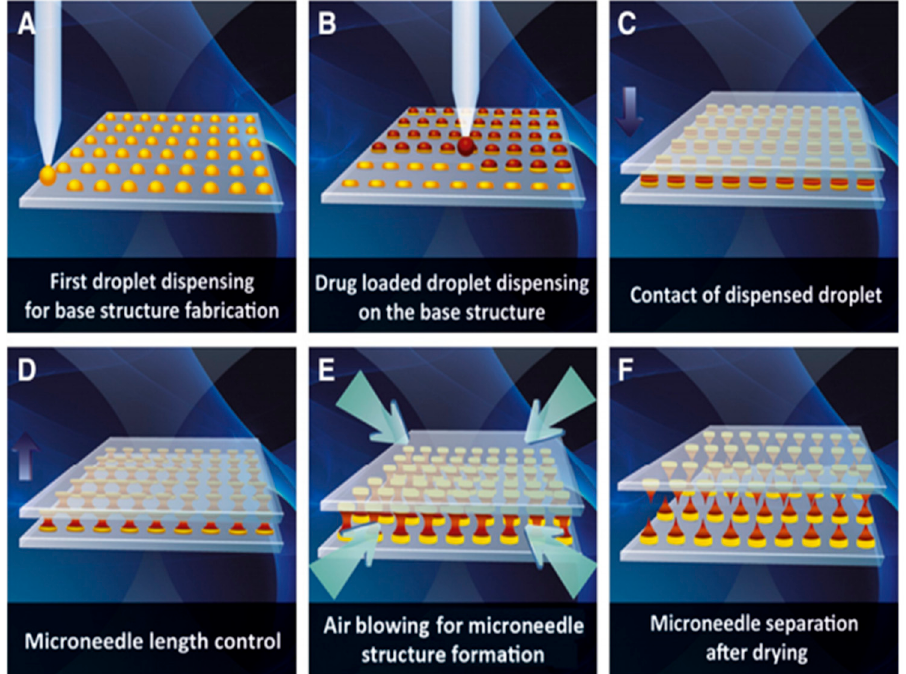
Figure 8. Schematic illustration of dissolving microneedle fabrication via droplet-born air blowing method. ( A ) Biopolymer dispensing on the flat surface for base structure fabrication. ( B ) Dispensing of drug-containing droplet over the base structure. ( C ) Contact of dispensed droplet by downward movement of upperplate. ( D ) Control of microneedle length. ( E ) Air blowing-mediated solidification of droplet to shape microneedle structure. ( F ) Separation of two plates producing dissolving microneedle arrays on upper and lower plates. Droplet-born air blowing (DAB) technology for fabricating polymeric MNs, reproduced with permission from [70], Elsevier, 2013.